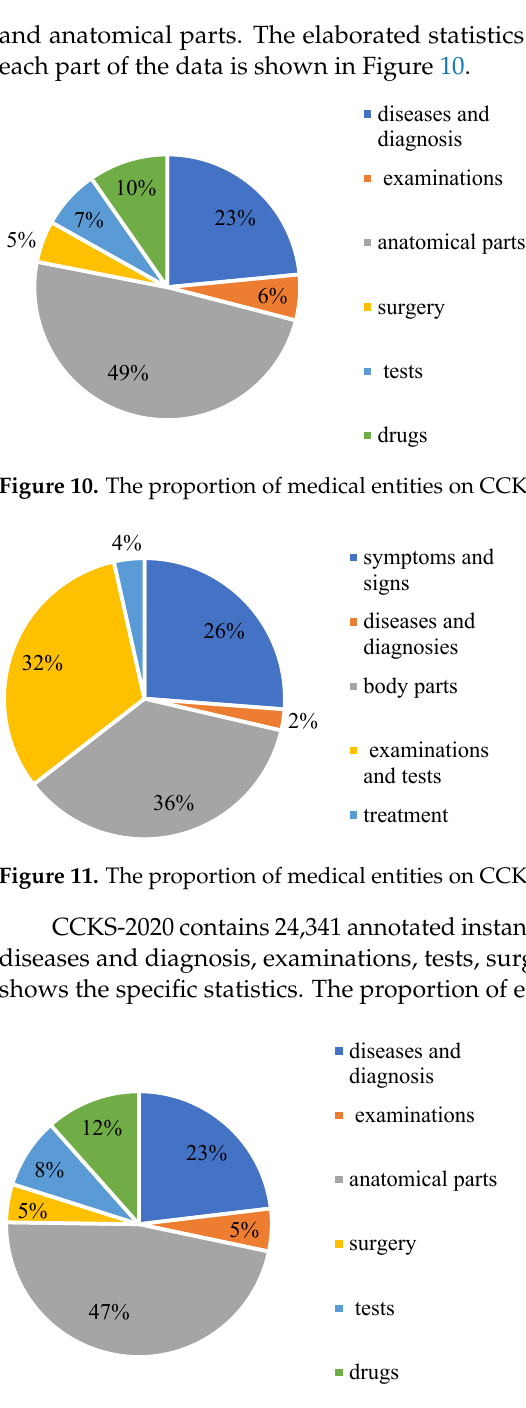
Figure 12. The proportion of medical entities on